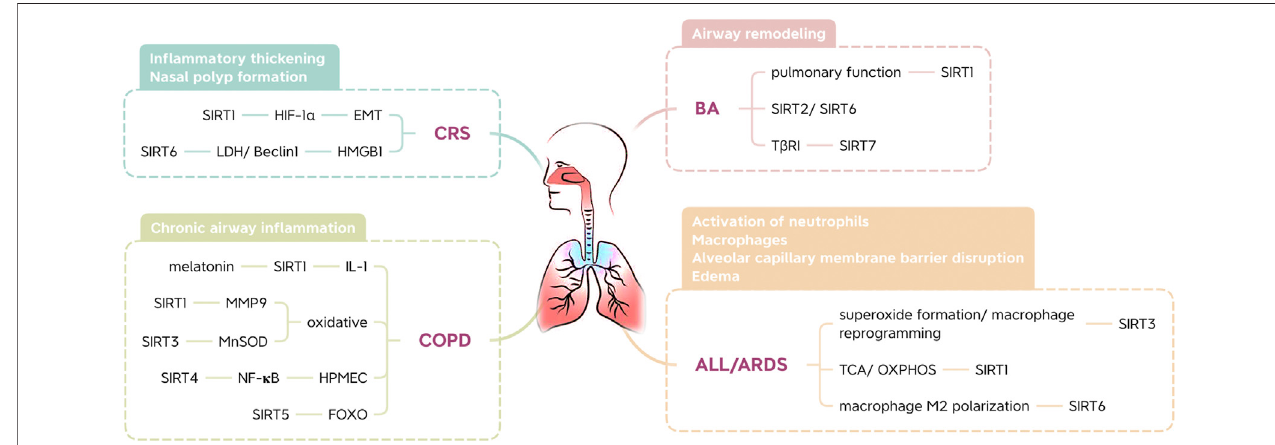
FIGURE 4 | The applications of SIRTs in in fl ammatory respiratory